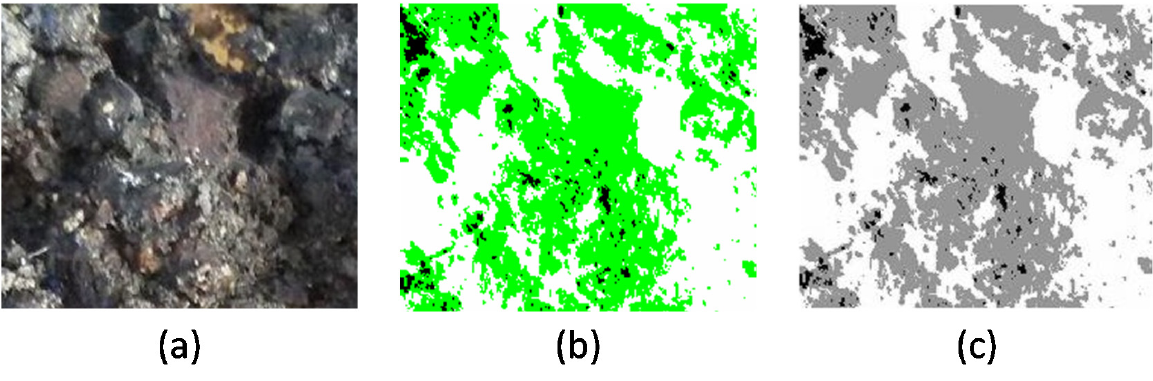
Figure 2. Image processing with ENVI and MATLAB (fractured samples subjected to indirect tensile testing): ( a ) image after test, ( b ) image processed by ENVI, and ( c ) image processed by